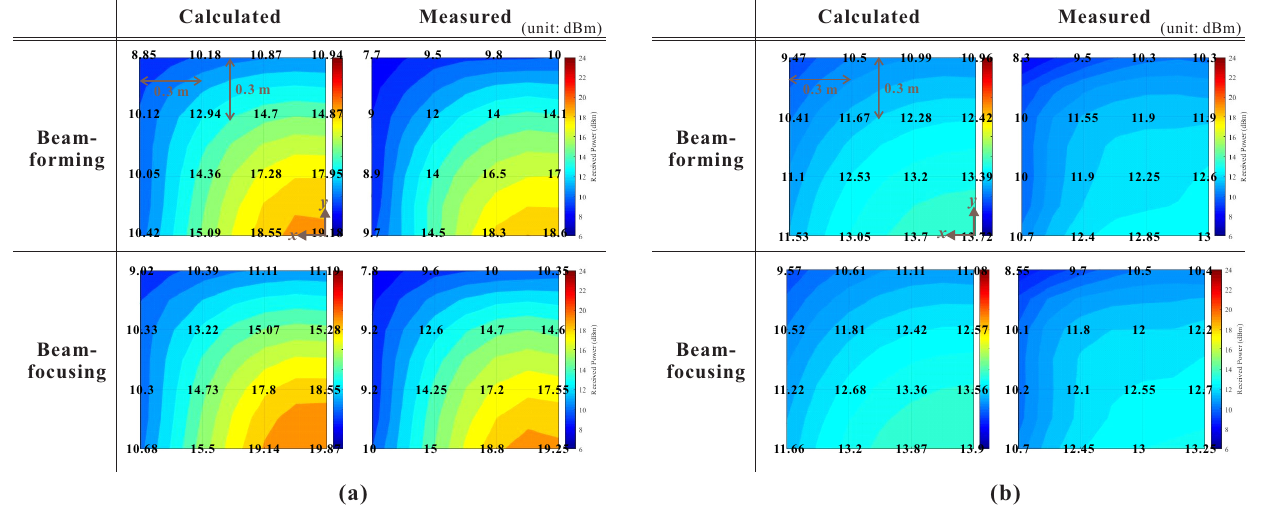
Figure 18. Distribution of the 5.73 GHz received power according to the Rx position:( a ) distance = 1 m; ( b ) distance = 2 m.